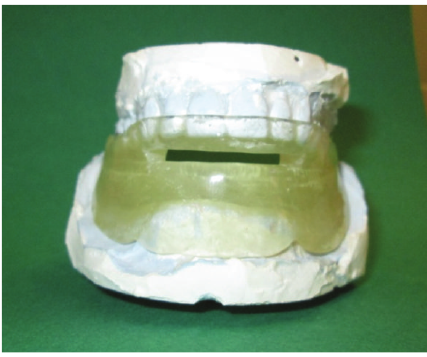
Figure 3: Device on the stone casts.